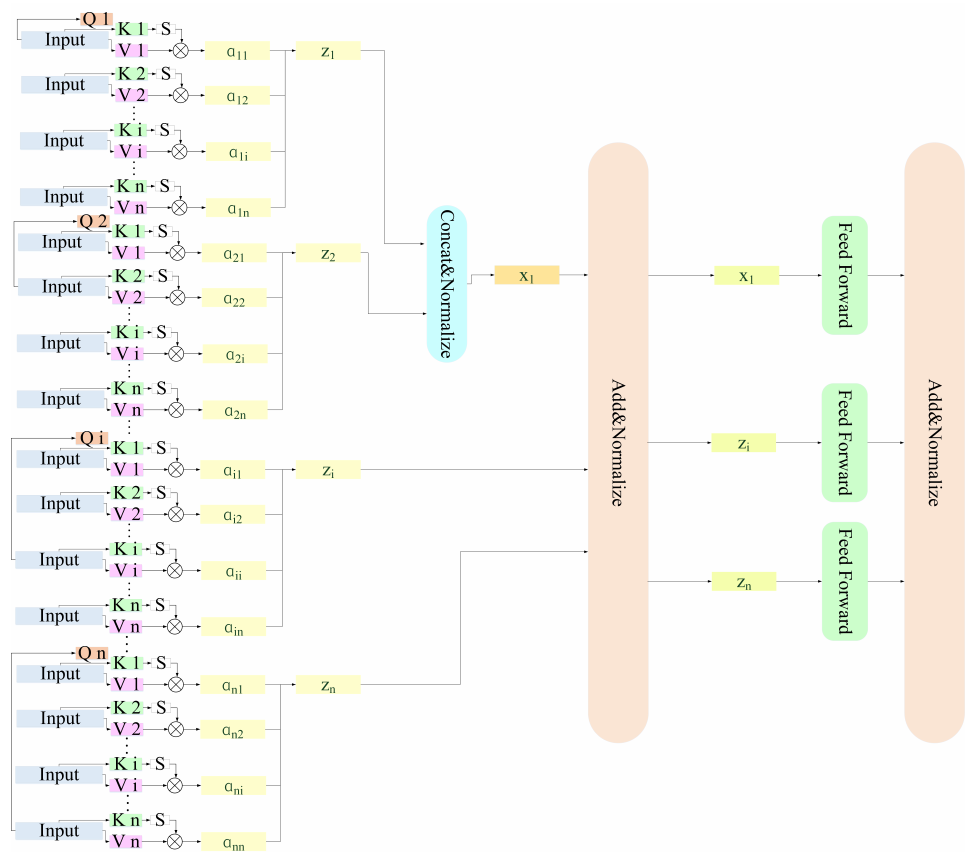
Figure 2. The detail of composition attention calculation. The context features are grouped into two parts where blocks with high correlations and other blocks are processed separately to disjoin style